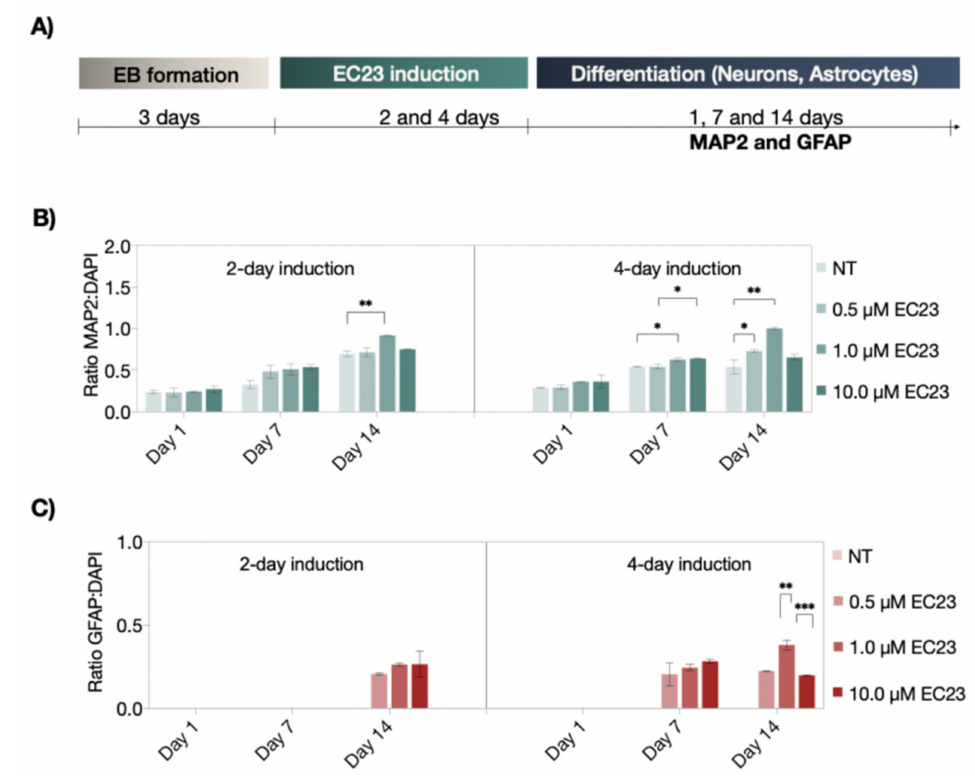
Figure 4. ( A ) Schematic representation of the neural differentiation protocol of EC23-induced neu- ronal and astrocytic differentiation. ( B , C ) Time-resolved expression of neuronal (MAP2; green) and astrocytic (GFAP; red) differentiation markers after two- and four-day treatment with concentrations of non-treated (NT), 0.5 µ M, 1.0 µ M, and 10 µ M of EC23 under static cultivation condition. Statistical significance was tested by using one-way ANOVA (* p < 0.05, ** p < 0.01, and *** p < 0.001), n = 2 ± SD. Bars without * do not represent statistical